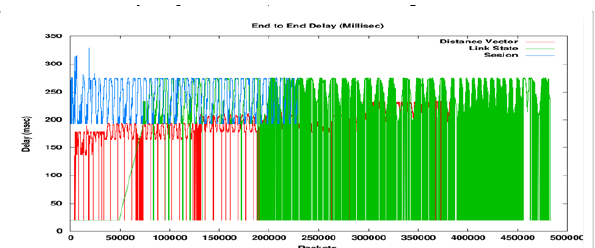
Figure 4: End to End Delay Comparison for DV, LS and Session Routing Protocols